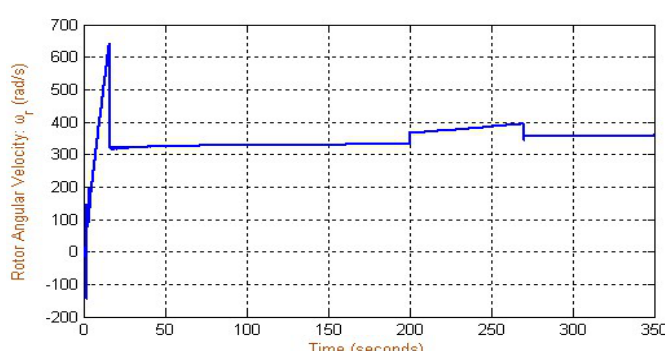
Figure 17. Set-point (SP) versus time.